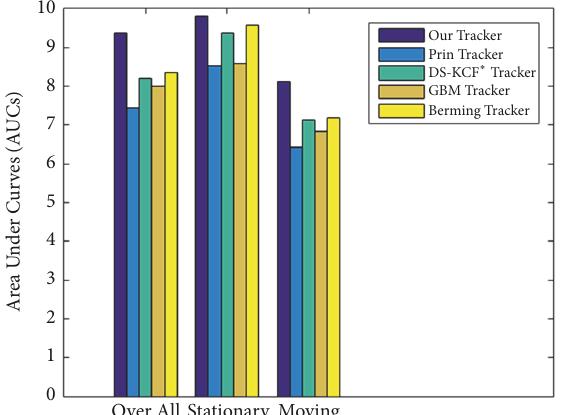
Figure 6: The comparison results of AUC on the BTB